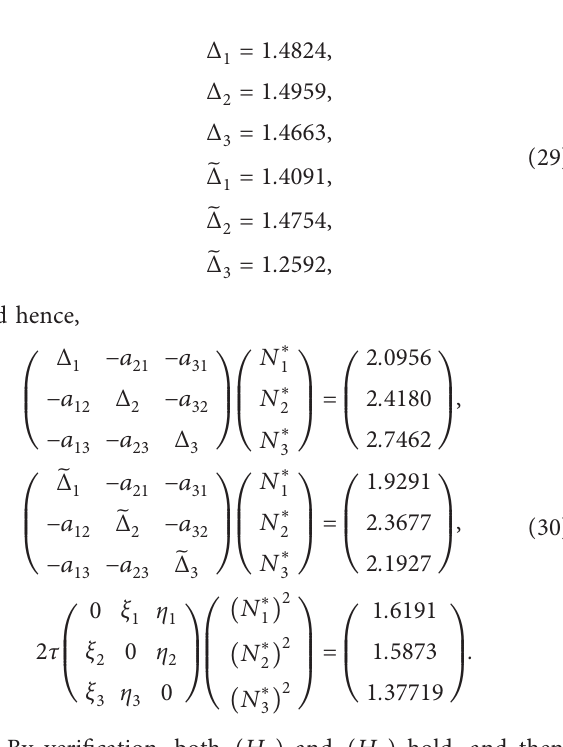
� 2 , σ � 2 , σ � 2 , and τ � 0 . 5; (b) for system (6), 1 2 3